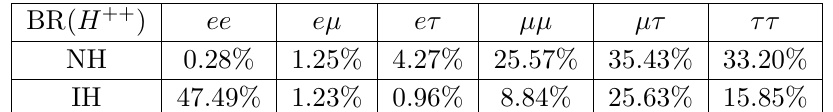
= Φ = 0 . The grey bands correspond to the current limit 1 2 from the cosmological data of P m 0 . 12 eV by the Planck i < 1(3)